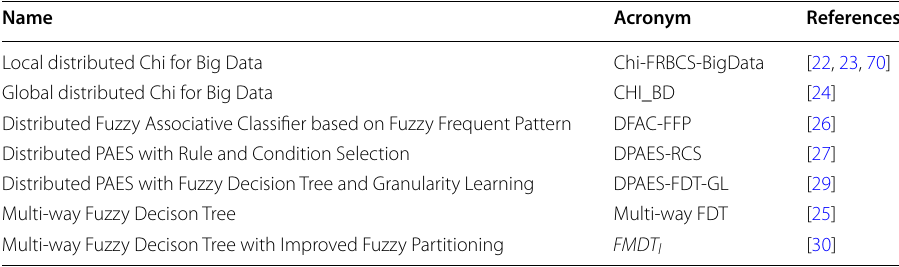
Table 1 Algorithms used in the experimental comparison